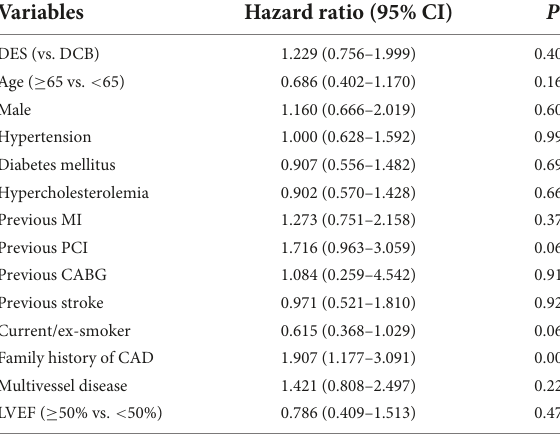
TABLE 6 Multivariate cox regression analyses of